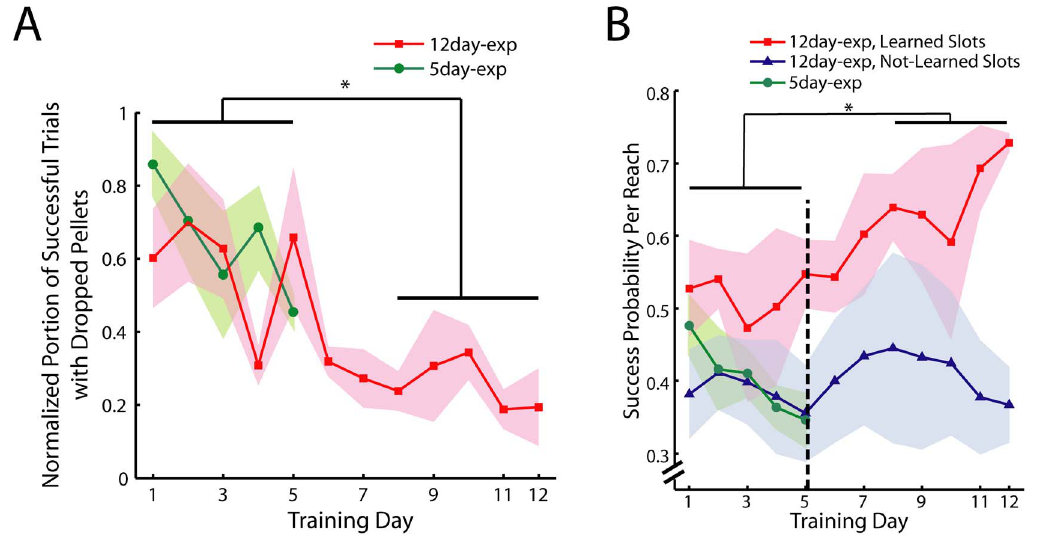
Figure 3. Rats used for microarray analysis exhibited motor behaviors similar to the behaviors of the whole rat group. A, The quality of the reaching behavior of the 4 rats in the 12-day-Reach group (red, mean 6 SE) showed much improvement over time with the percentage of successful trials with dropped pellets of Day 8 to 12 being clearly lower than that of Day 1 to 5 (*, p , 0.05, ANOVA). Similarly, a decreasing trend of this measure of learning was also observed in the 5-day-Reach group (green). In this figure we have normalized the learning curve of every rat to its maximum value to account for inter-individual variability in initial performance. B, The probability of successful pellet retrieval per reach for the rats in the 12-day-Reach group over the Learned (red, mean 6 SE) and Not-Learned (blue) Slots. Similar to the behavioral trend of the whole rat group (Fig. 2D), the learning curve for the Learned Slots exhibited a sigmoid time course, with performance starting to increase at Day 5.1 6 3.2 (t 10%-max , black dotted line, mean 6 SE), and with the probability values of Day 1 to 5 smaller than those of Day 8 to 12 (*, p , 0.05, ANOVA). The success probability values for the 5-day-Reach group (N=4; green; all slots) were also not statistically different from the values for the 12-day-Reach group over the first 5 days (p . 0.05,